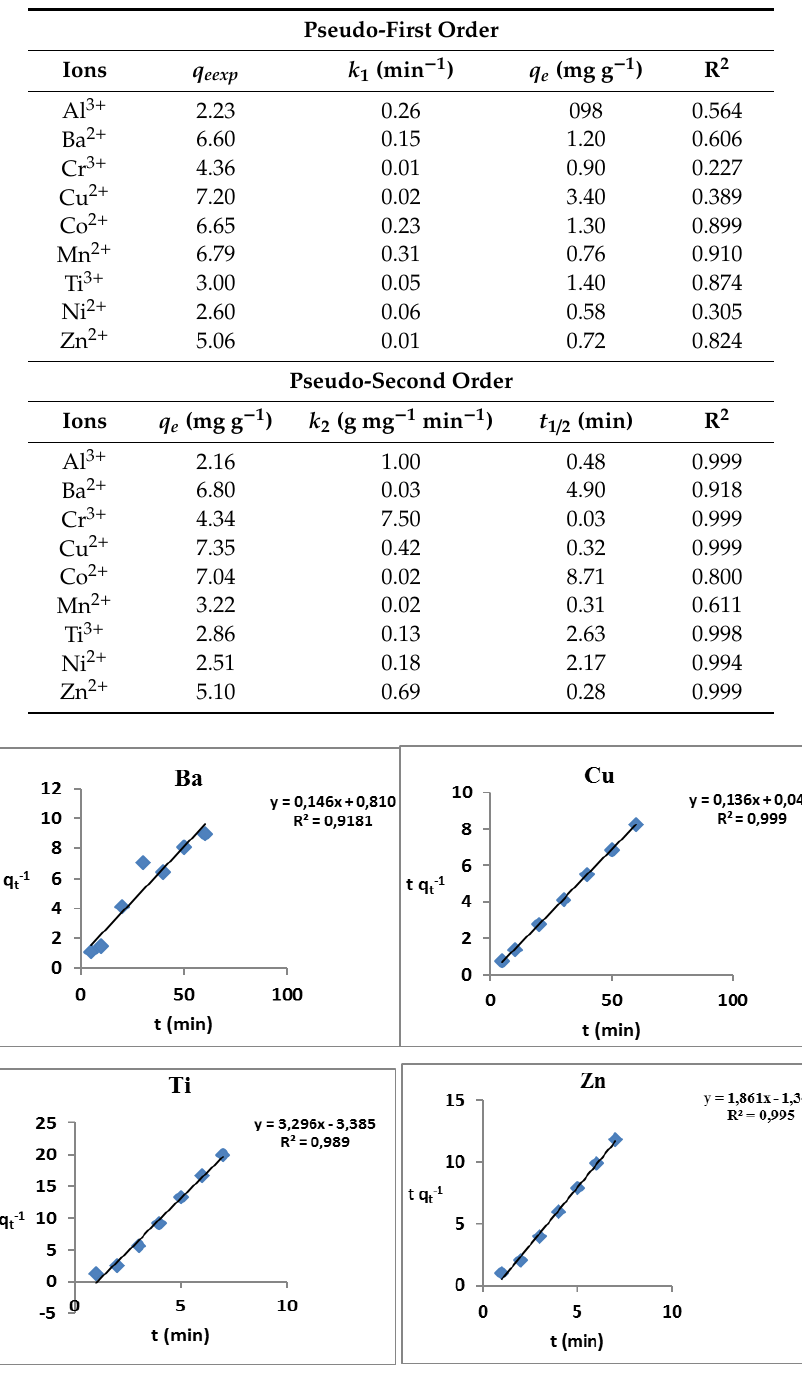
Figure 8. Graphs of pseudo-second order equation for Ba 2+ , Cu 2+ , Ti 4+ and Zn 2+ .